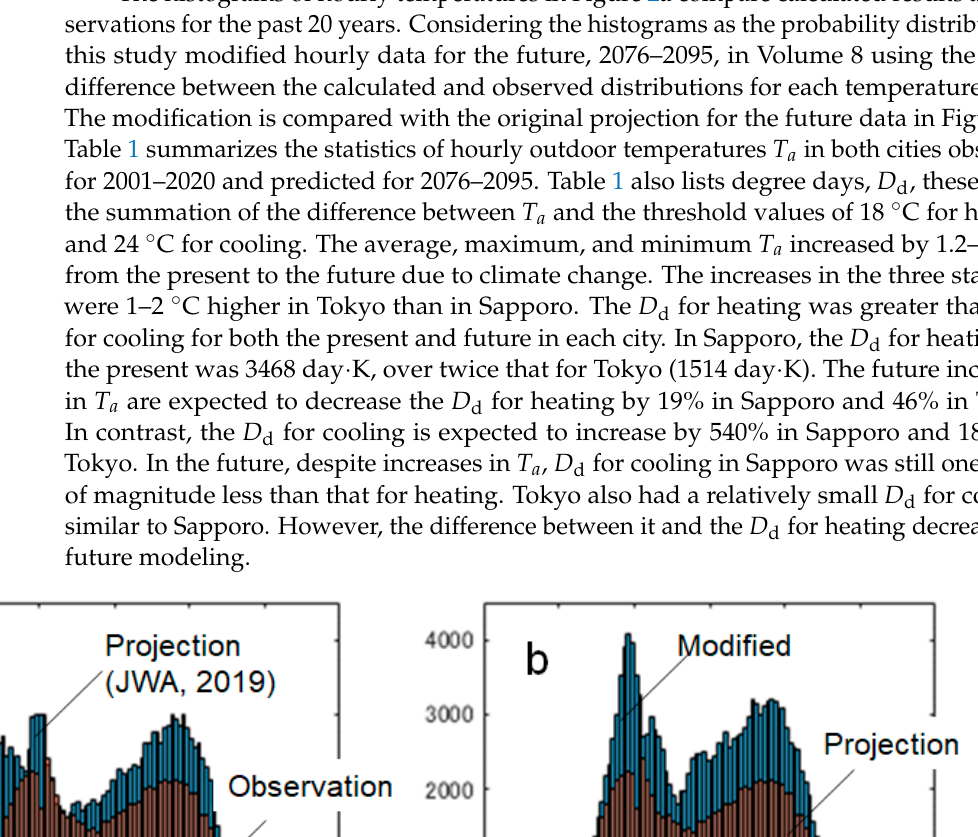
The histograms of hourly temperatures in Figure 2a compare calculated results and ob- servations for the past 20 years. Considering the histograms as the probability distributions, this study modified hourly data for the future, 2076–2095, in Volume 8 using the linear Table 1. Summary of outdoor temperature T a and degree days D d for the present (2001–2020) and future (2076–2095) in Sapporo and Tokyo, Japan. Future data were modified from JWA (2019), as the probabilistic distributions for 1981–1999 were matched to the projections. Degree days are the summation of differences between daily averaged temperatures and thresholds, 18 °C for heating and 24 °C for cooling.